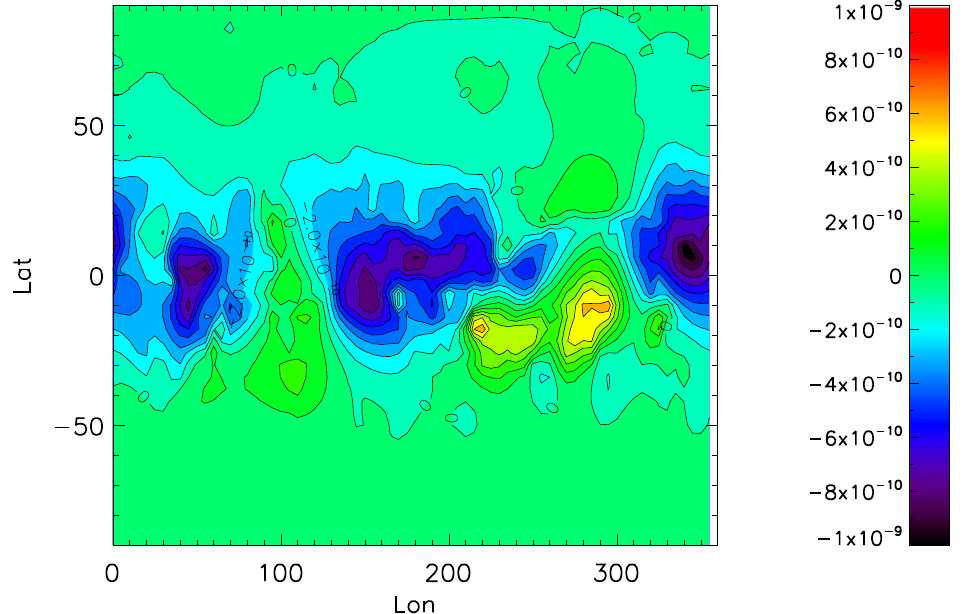
Figure 1. Added torque (m / s 2 ) in our lowest model layer at 170 m altitude. Warm colors are prograde (westerly) and cool colors are retrograde